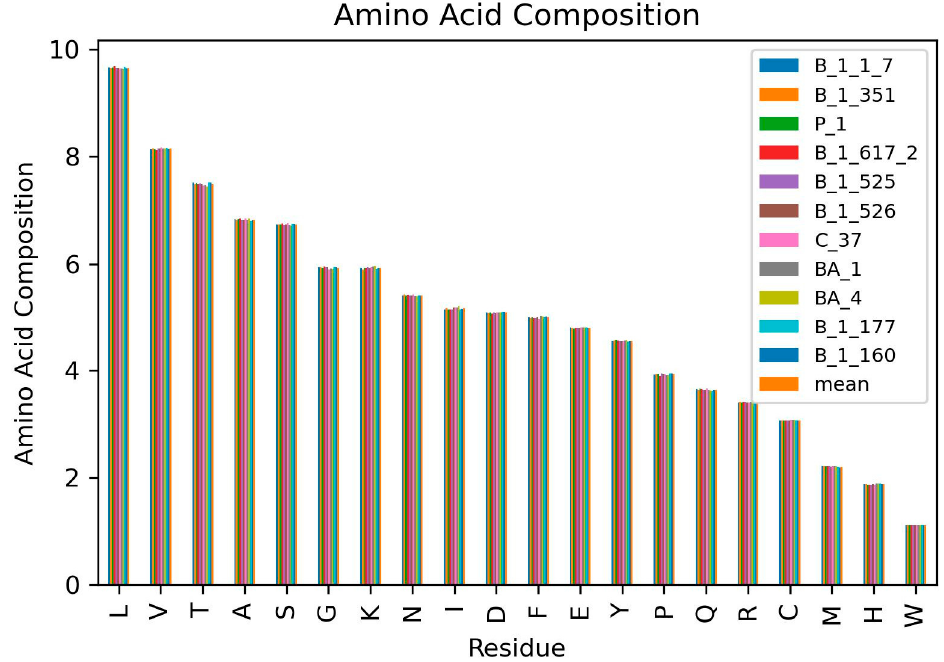
Figure 2. Amino acid composition of the 11 SARS-CoV-2 variants.